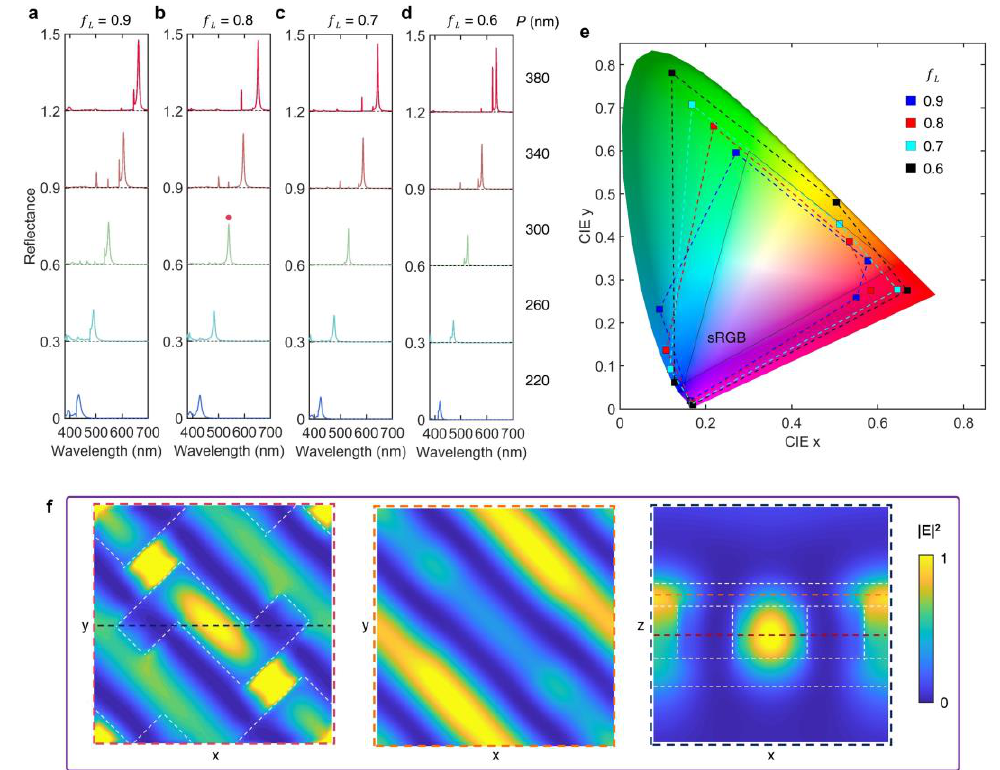
Figure 2. The color performance of simulated embedded chiral metasurface with different f L and P. The cross‑polarization reflectance spectra and corresponding micrographs with f L of ( a ) 0.9, ( b ) 0.8, ( c ) 0.7, and ( d ) 0.6 at different p from 220 nm to 380 nm. ( e ) The corresponding CIE 1931 chromaticity diagram of ( a – d ). ( f ) The square of the absolute of the electric field distributions | E | 2 at the xy- and xz-plane of resonant peaks in ( b ) marked by a magenta dot.